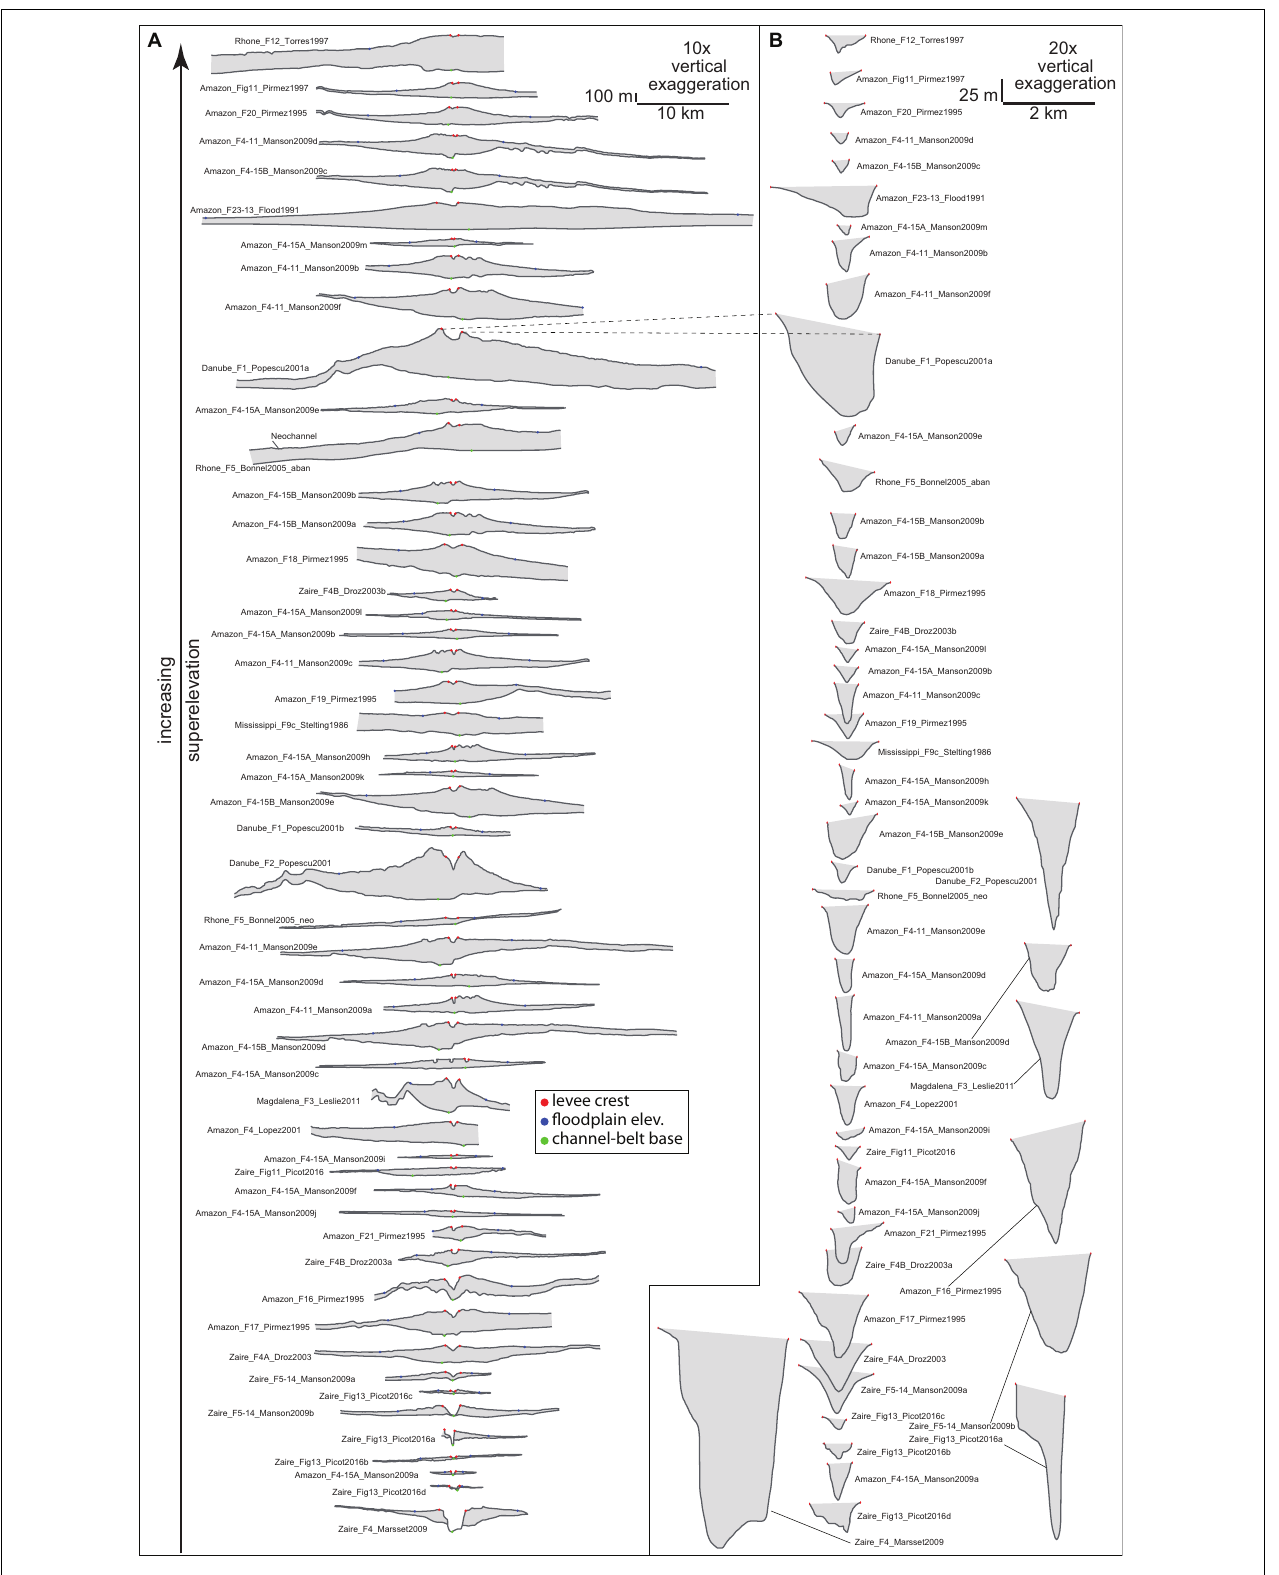
FIGURE 3 | Line tracings of 52 seismic-reflection profiles that compose this study’s dataset. (A) Channel-belt cross-sections with red, blue, and green points showing the levee crest, floodplain elevation (i.e., base of levee), and channel-belt base, respectively. Cross-sections ordered from bottom to top in ascending superelevation value. (B) Zoom-in from part A of each channel, with levee crest points shown in red.